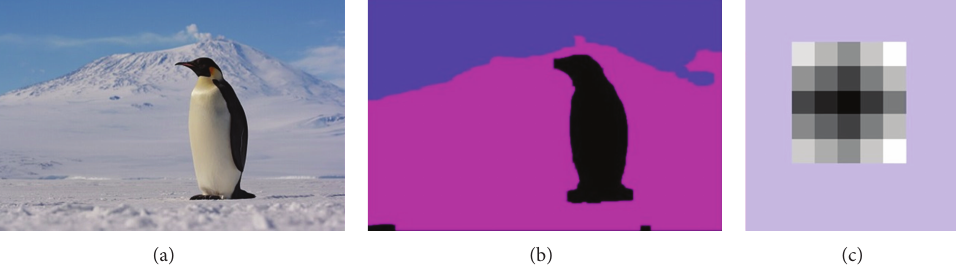
Figure 4: Nodes and contextual